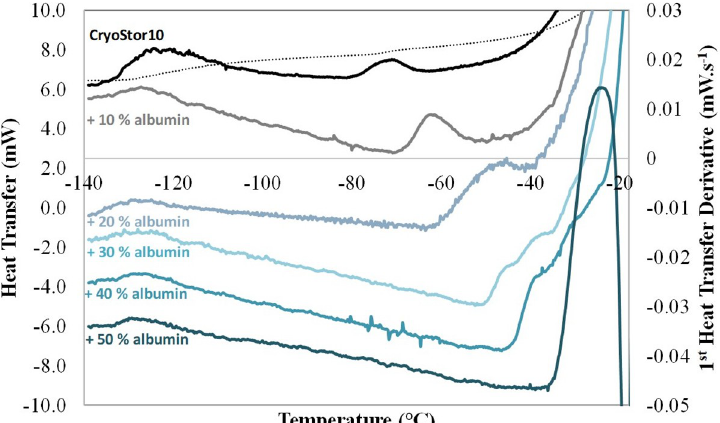
Fig 3. First-order derivatives of the DSC traces of mixtures of CryoStor10 and serum albumin during warming at 10˚C min -1 following cooling at -10˚C min -1 . The following percentages, by weight, of albumin dissolved in CryoStor10 are identified by trace colour and are: black, 0%; grey, 10%; grey-blue, 20%; light blue, 30%; blue, 40%; dark blue, 50%. The raw DSC trace of CryoStor10 is also included (dotted black